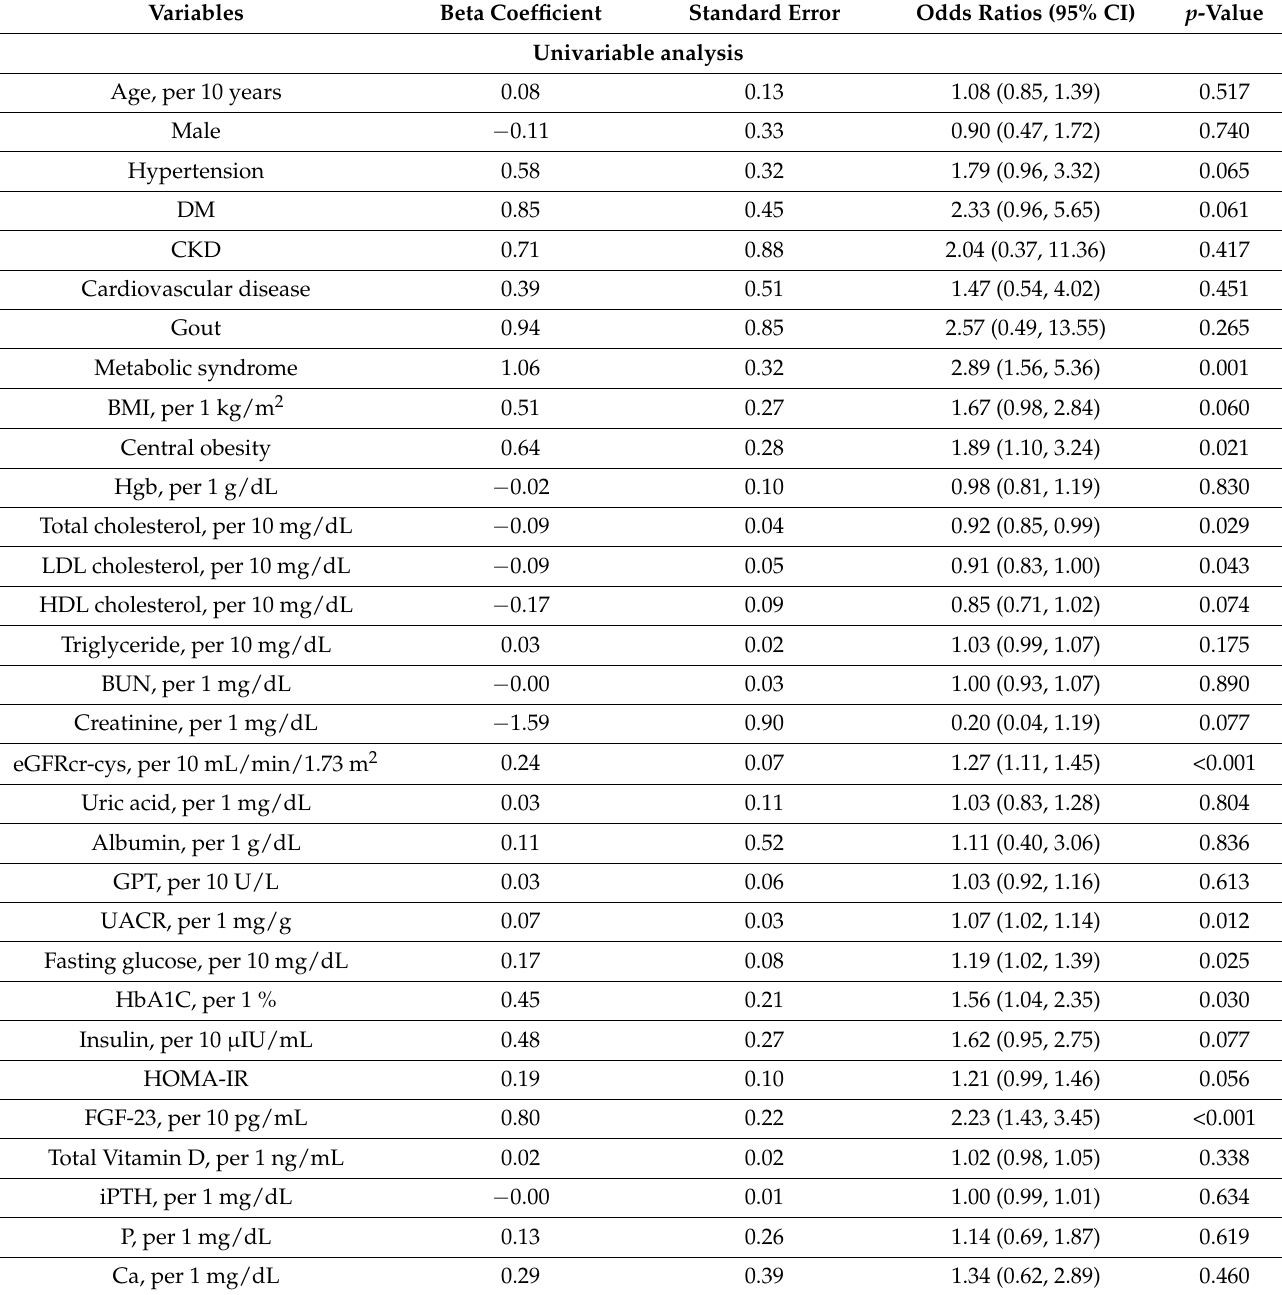
Table 2. The prognostic significance of our variables for